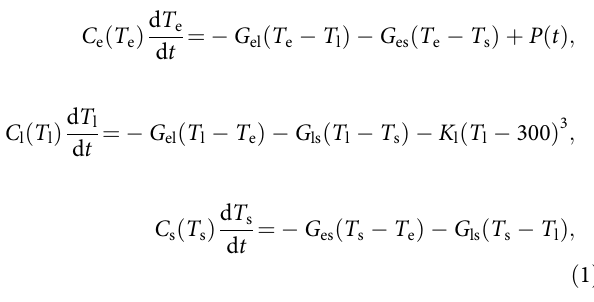
Table 1. In case of n = 15, the equilibrium temperature, T eq , where T e becomes equal to T l for the fi rst time is ~ 937 K at t = 8.5 ps under zero fi eld. In the case of n = 5, T eq ~ 1232 K at t = 65 ps under a zero fi eld (not shown). As T s is related to the magnetization, which is a magnetic ordering parameter, the lower T s indicates a higher degree of magnetization (or equivalently larger remagnetization). The fi tting results (Table 1) indicate that G el increases in proportion to n , as previously reported for the